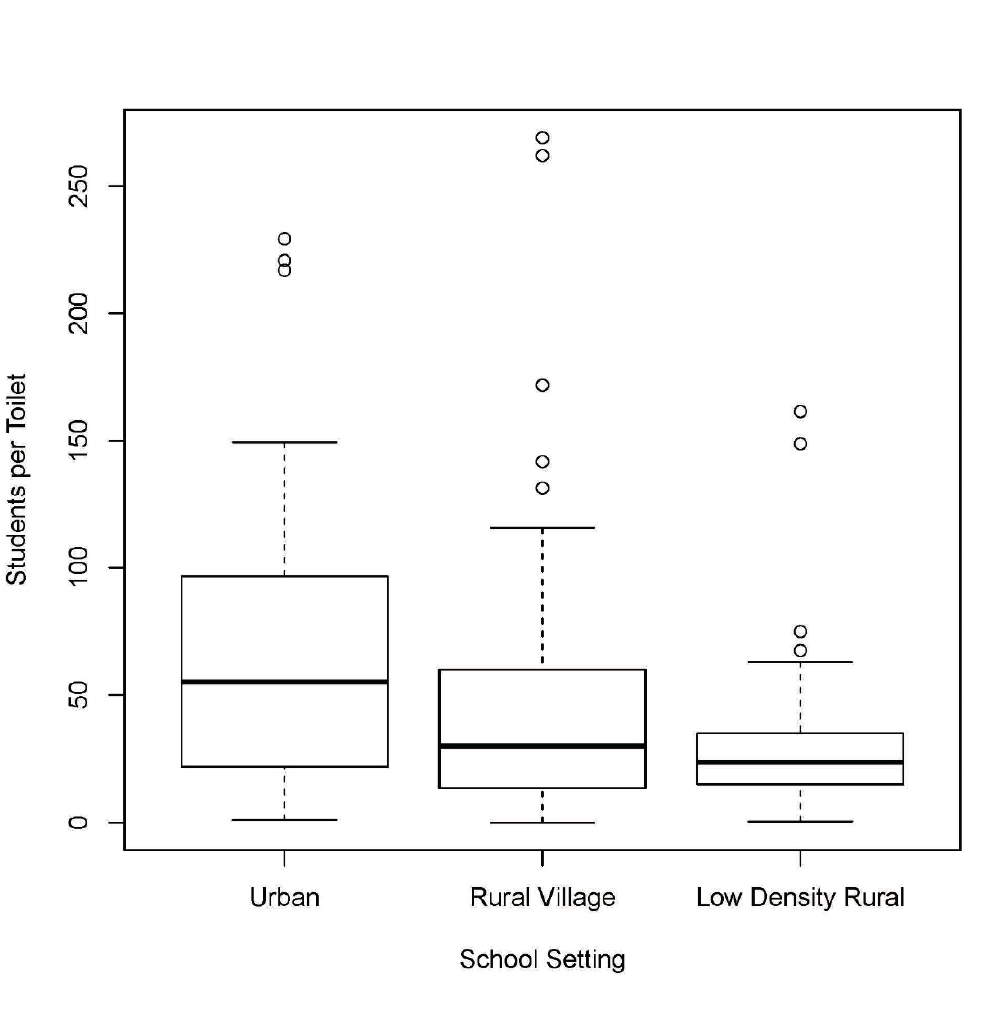
Figure 2. Student to toilet ratio for schools with at least one toilet, by school